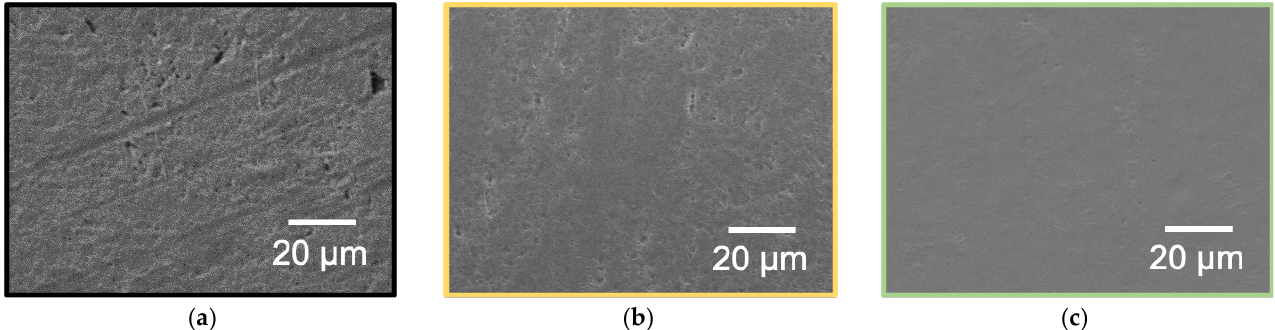
Figure 6. SEM images of the PTFE samples HAP-treated using He or Ar gas. ( a ) As-received PTFE, ( b ) He HAP-treated PTFE, and ( c ) Ar HAP-treated PTFE.